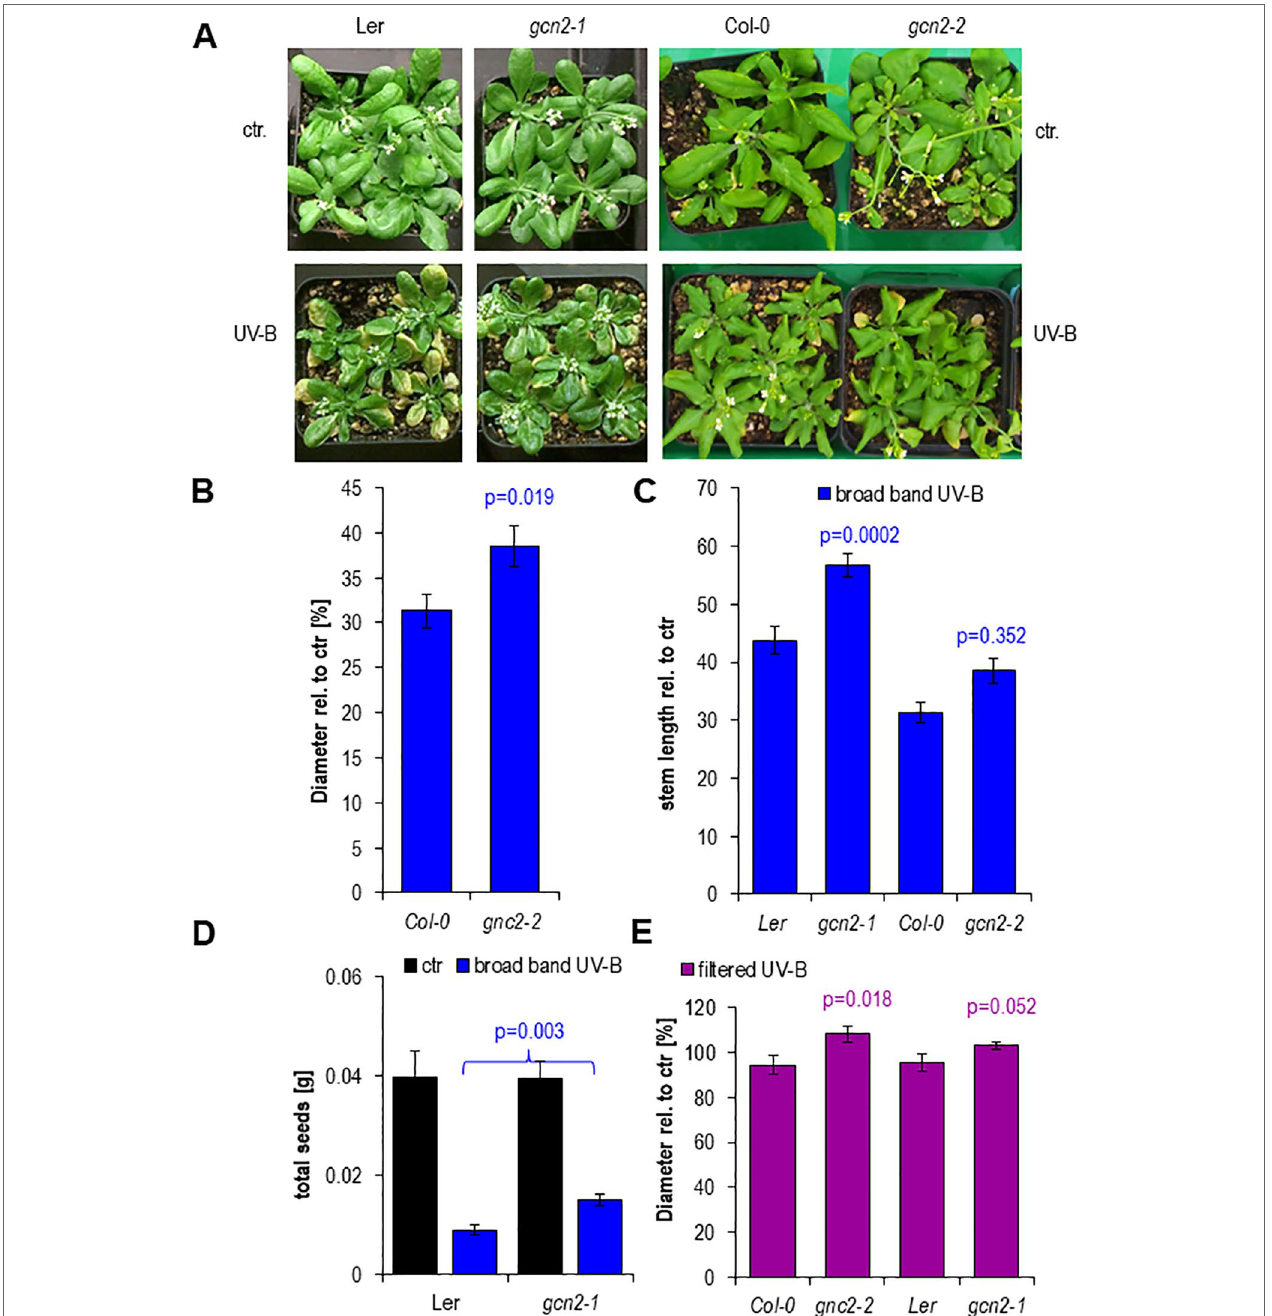
FIGURe 7 | Phenotypes after 15 days of chronic UV-B exposure. (A) Rosettes of wildtype and gcn2 mutants after a 1 h daily dose with 6 µmol m -2 s -1 UV-B broad band UV-B. (B) Quantification of rosette diameters of 18 to 21 plants. (C) Quantification of the stem lengths of 9 to 20 plants. (D) Quantification of the total seed weight of 9 to 19 plants. (e) Quantification of rosette diameter under chronic filtered broad band UV-B of 10 to 25 plants. Bars represent means and SE. Statistical differences between wildtype and mutants were calculated with Student’s t- test and p-values are indicated above each bar. Numbers of plants are designated in the respective